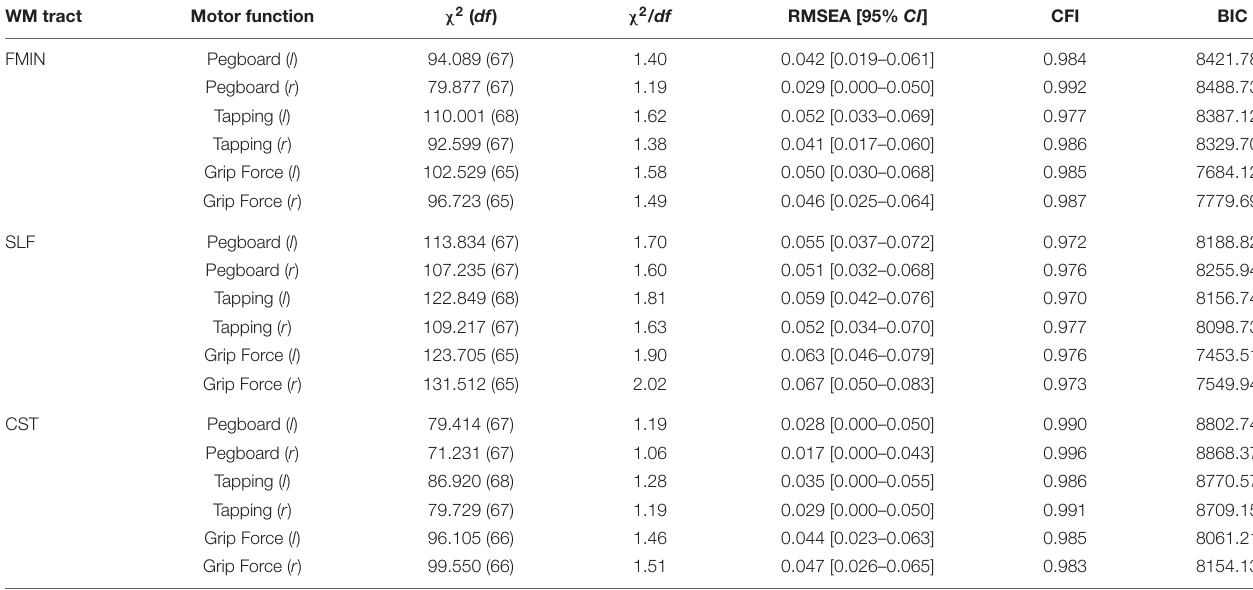
TABLE 8 | Model fit statistics of bivariate LGC models (for parameter estimates see Table 9 ). WM